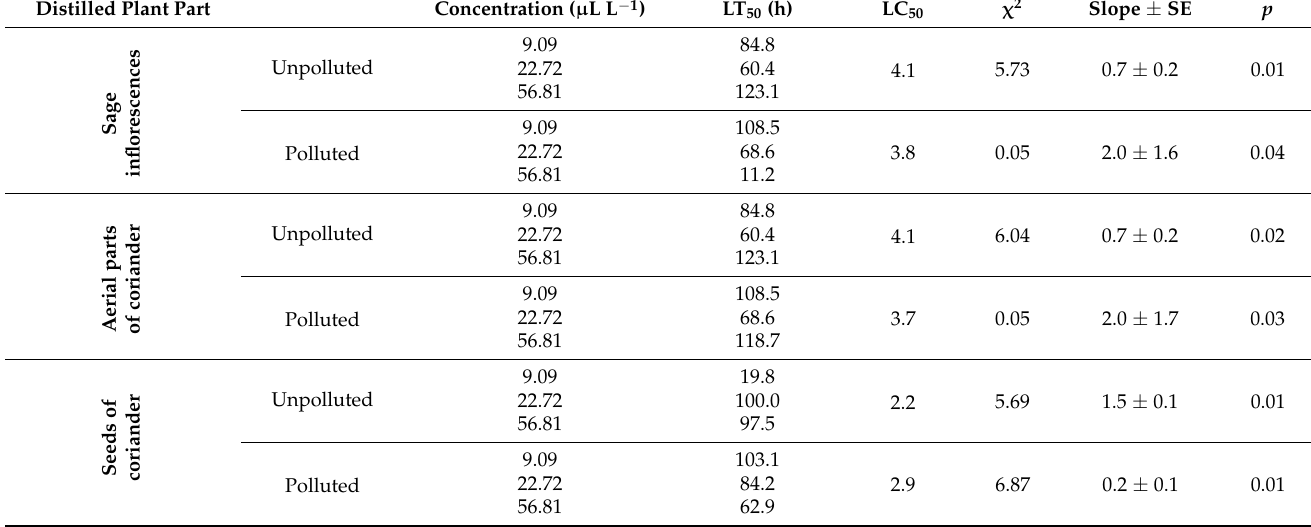
Table 7. LT 50 (h) and LC 50 ( µ L L − 1 ) values resulting from the fumigation bioassay against R. dominica adults, for the three different tested EO, originating from the two experimental plots (n =